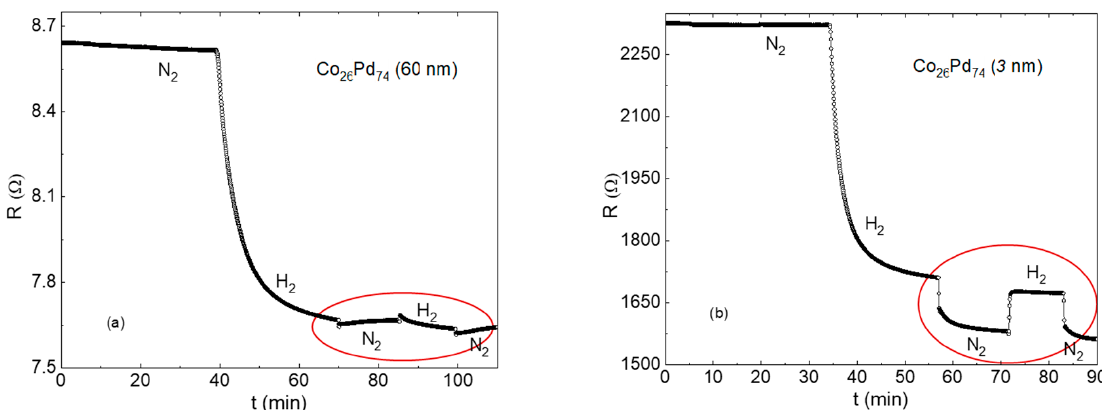
Figure 6. Resistance response of 60 nm ( a ) and 3 nm ( b ) thick Co 26 Pd 74 films to the sequences of hydrogenation and dehydrogenation cycles. The H scattering terms are marked by ellipses. The background resistance decrease is due to a gradual thickness expansion in the hydrogen atmosphere.